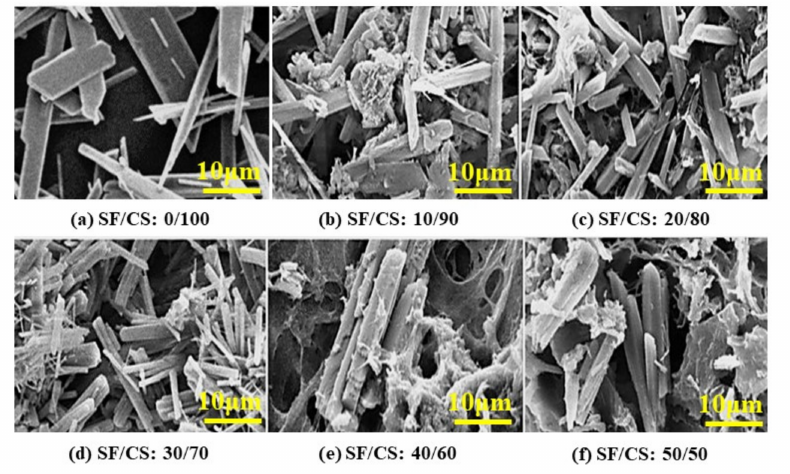
Figure 4. Representative SEM images of the various SF/CS composites, ( a ) SF/CS: 0/100, ( b ) SF/CS: 10/90, ( c ) SF/CS: 20/80, ( d ) SF/CS: 30/70, ( e ) SF/CS: 40/60, ( f ) SF/CS: